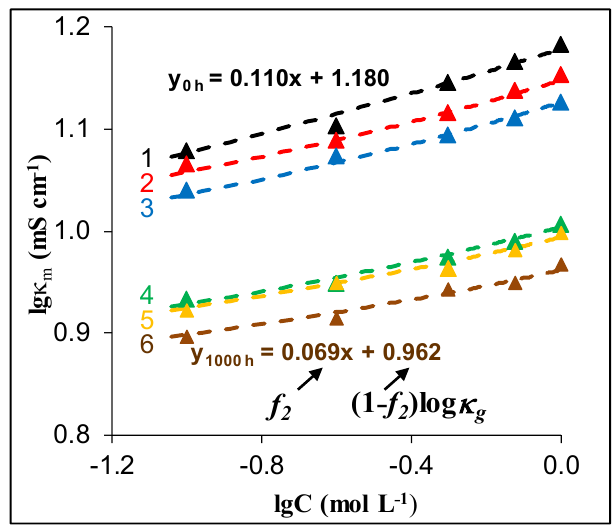
Figure 23. The conductivity of the AEMs soaked in the synthetic polyphenol-containing solution vs. NaCl concentration. Markers show the experimental data measured for sample soaking durations 0 (1), 24 (2), 100 (3), 500 (4), 750 (5) and 1000 (6) h; dashed lines are the results of calculations according to the modified microheterogeneous model. Adapted from [41]. Table 6. Parameters of the modified microheterogeneous model [41] calculated for the AEM samples soaked with the synthetic polyphenol containing